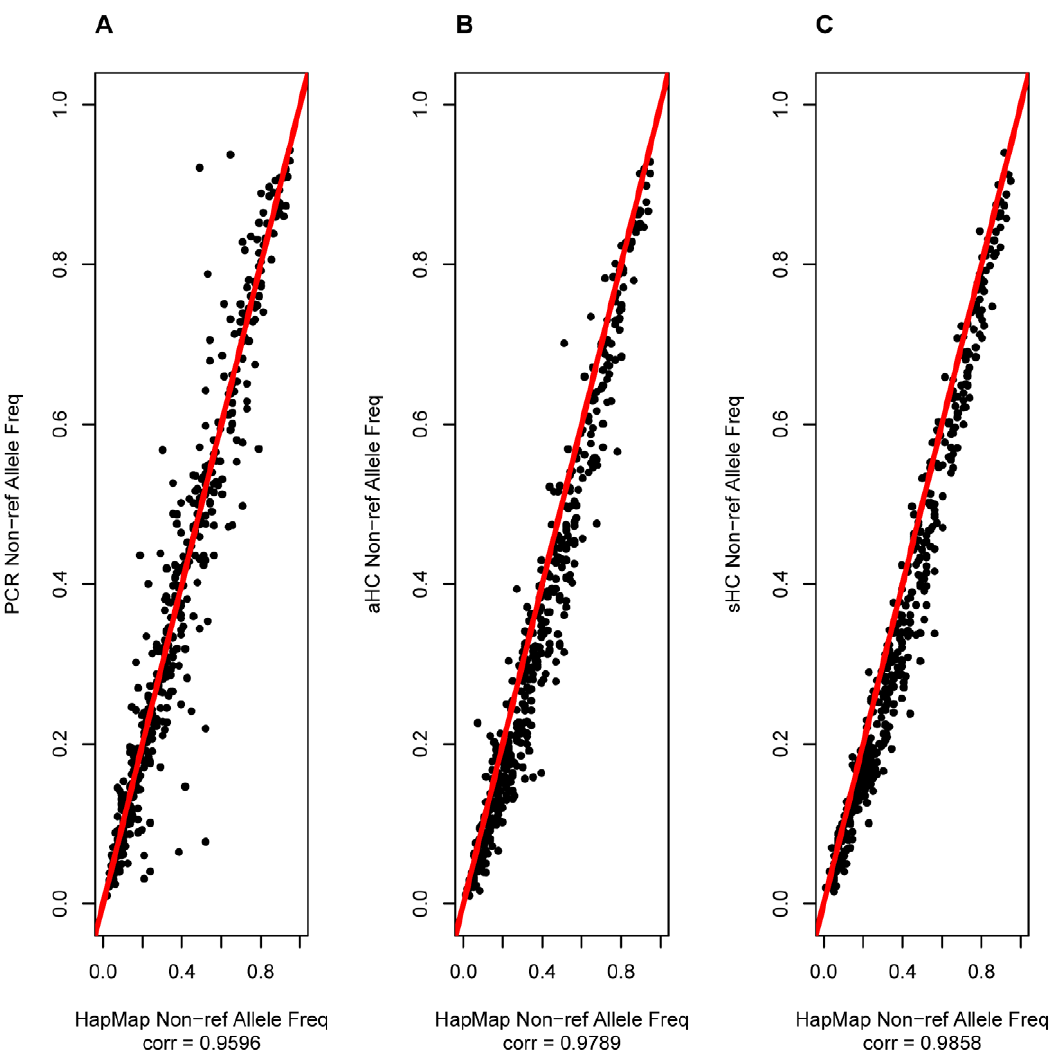
Figure 3. Accuracy of non-reference allele frequency estimation at HapMap/58C intersection variants for the Pool of 50 before duplicate removal. An analysis of the correlation between the non-reference allele frequency estimates from the sequencing based variant caller and the allele frequency calculated from the reference genotypes. The analysis includes the true positive variants called by the sequencing based variant caller for which there were ƒ 2 missing genotypes in the reference genotypes. The correlation coefficient is the Pearson’s correlation coefficient. The figure shows the analysis for: (A) PCR, (B) aHC and (C) sHC enrichment.